Question: In one sentence, what is this figure communicating?
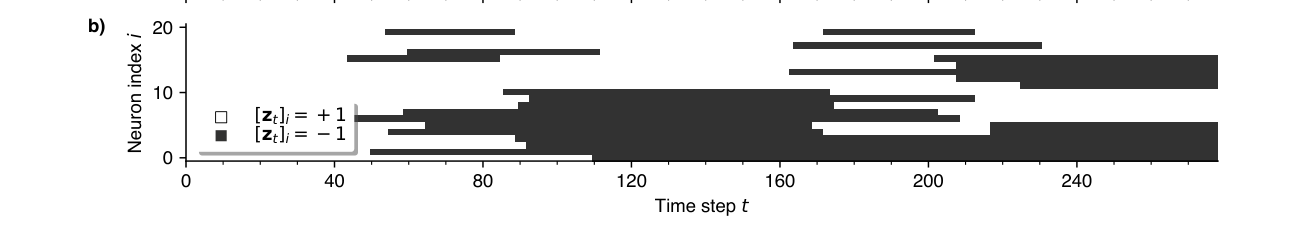
Answer: An attractor network performing a shorter walk than in Figure 2, but where neurons are updated asynchronously, with each neuron having a 10% chance of updating on any time step. a) The similarity of the network state zt to stored node hypervectors, with the stimulus hypervectors being applied to the network labelled above. b) The evolution of a subset of neurons within the attractor network, where for visual clarity, three of the node hypervectors have been taken from columns of the N-dimensional Hadamard matrix, rather than being randomly generated. The network functions largely the same as in the synchronous case, but with transitions between attractor states now taking a finite number of time steps to complete. The model is thus not dependent on the precise timing of neuron updates, and should function robustly in asynchronous systems where timing is unreliable.